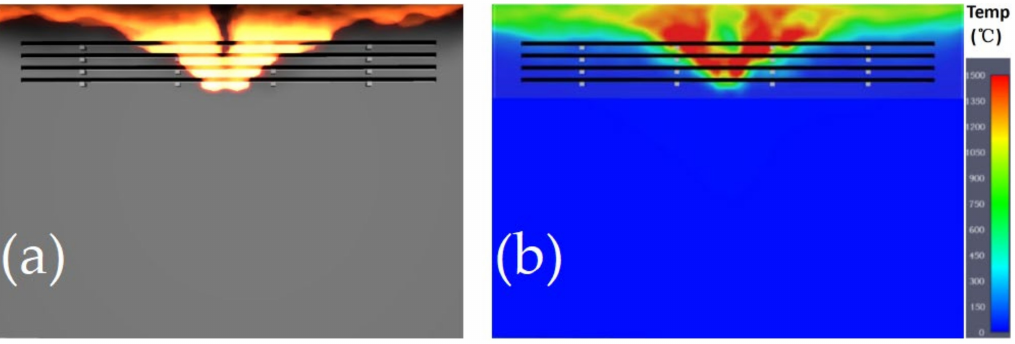
Figure 5. ( a ) Cable burning condition; ( b ) temperature slice.